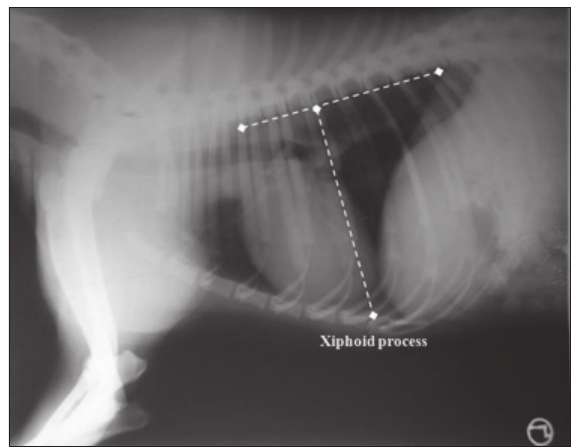
Figure-2: Thoracic depth measured from xiphoid process to the perpendicular of vertebral column in lateral recumbency.